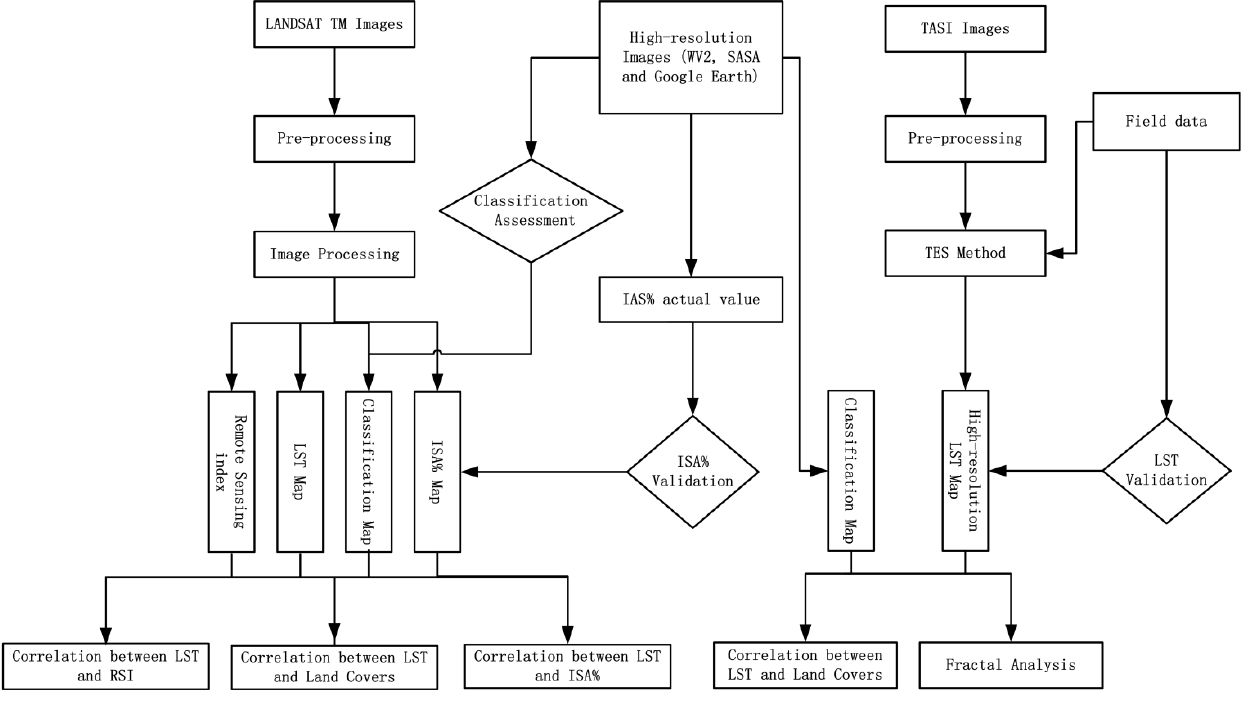
Figure 2. Overall process